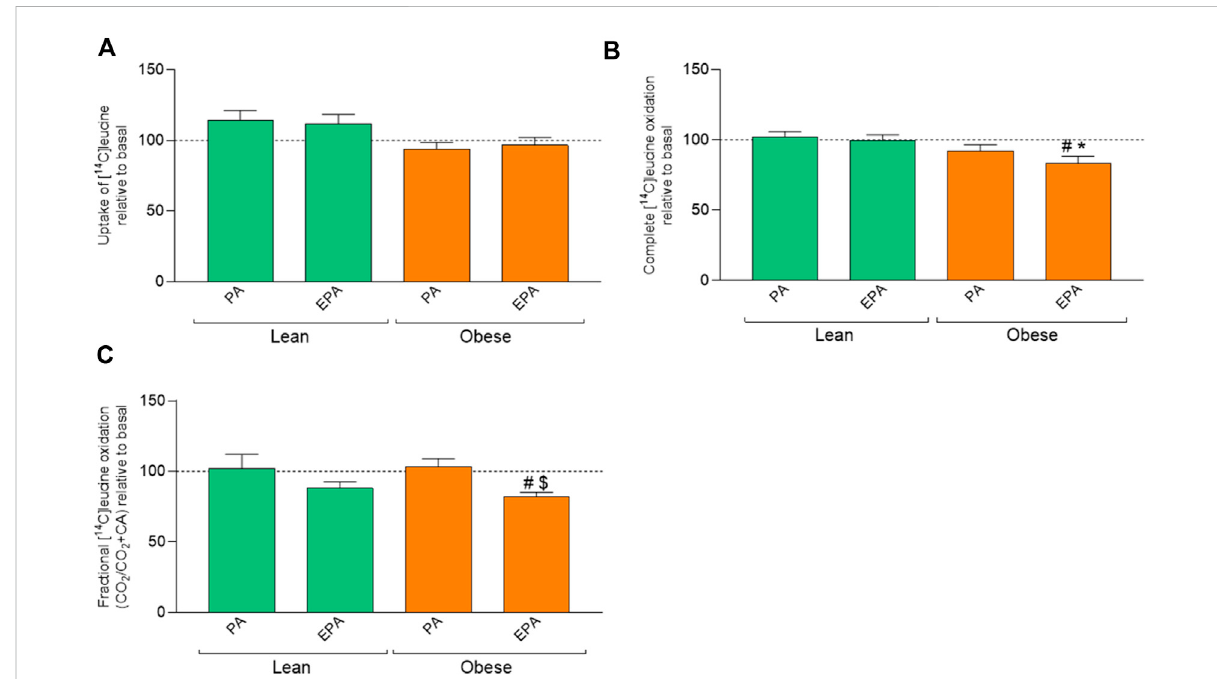
FIGURE 5 Effects of preincubation with fatty acids on leucine metabolism in myotubes from lean and donors with obesity. Differentiated skeletal muscle cells (myotubes) from lean or donors with obesity were preincubated with either no fatty acid (basal), PA (100 µM) or EPA (100 µM) for 24 h, and thereafterincubatedwith[ 14 C]leucine (800 µM)for 4 h.The fi guresshow: (A) totaluptakeofleucineinthecells(CO 2 +CA), (B) complete oxidationof leucine to carbon dioxide (CO 2 ), and (C) fractional leucineoxidation (CO 2 /uptake). Results present means± SEM ( n =8). Resultsfor lean group, basal (without treatment) was set to 100%, and for obese group, basal (without treatment) was set to 100%. Statistical signi fi cance was calculated as the difference between the two groups using one way ANOVA, and these differences were considered signi fi cant if # p ≤ 0.05 vs. basal for cells from the same group, * p ≤ 0.05 vs. respective treatment for the lean group and $ p ≤ 0.05 vs. PA from the same